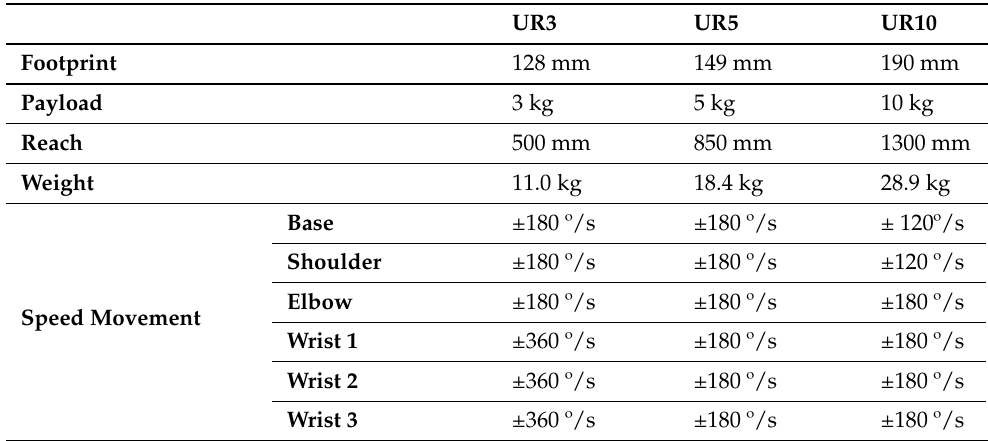
Table 1. UR Robots